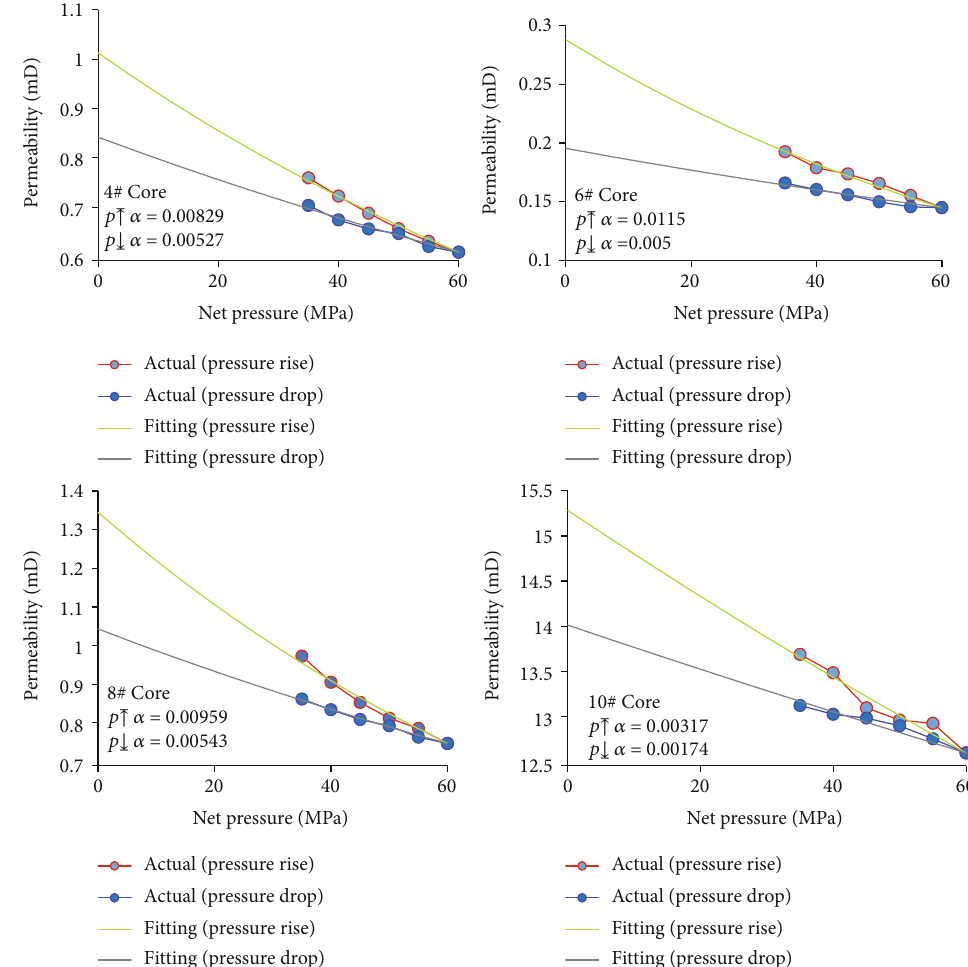
Figure 4: Permeability variation and fi tting of core during step-up and down-pressure